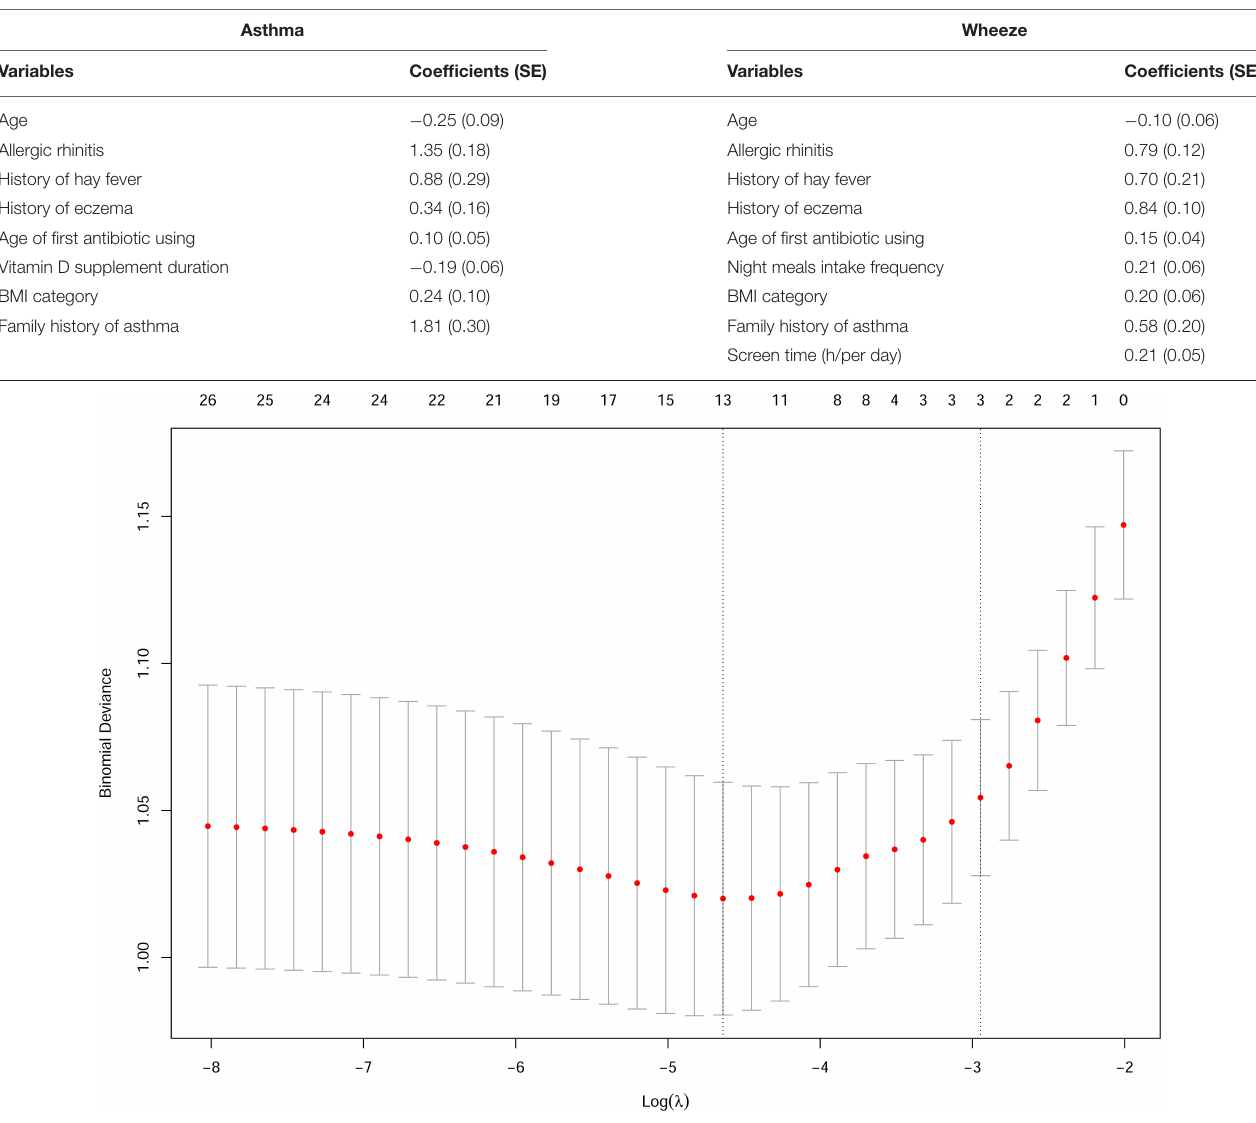
TABLE 3 | The estimated coefficients for logistic least absolute shrinkage and selection operator (LASSO) regression between candidate risk factors with doctor-diagnostic childhood asthma and parent-reported wheeze.